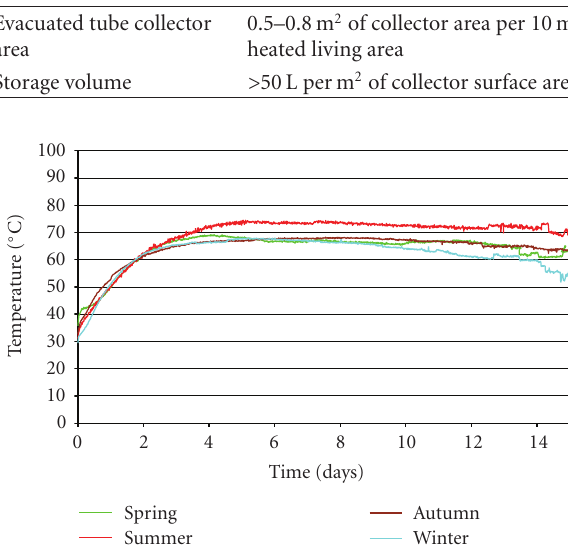
Figure 4: Average temperature temporal profiles: seasonal compar- ison.